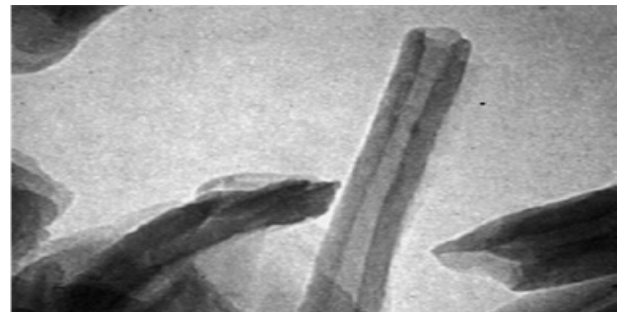
Figure 2. TEM micrograph of HNTs [21].